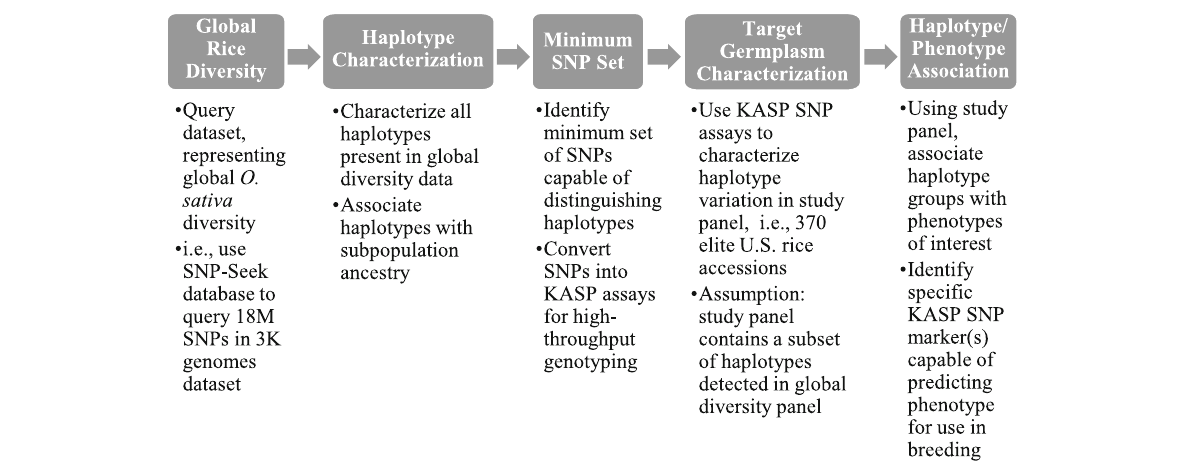
Fig. 1 Haplotype Characterization and Phenotypic Validation Workflow. Legend: Workflow utilized to leverage publicly available genomic information to develop a KASP SNP marker for targeted application in U.S. rice breeding